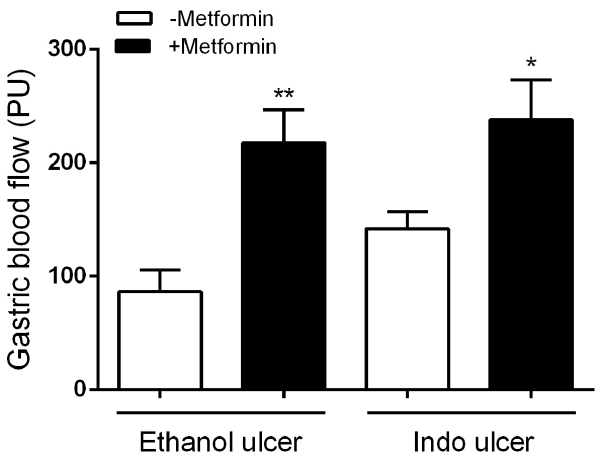
Figure 6. Gastric blood flow values of the experimental groups. Data are expressed as mean ± SEM. * P < .05 versus indo ulcer group; ** P < .01 versus ethanol ulcer